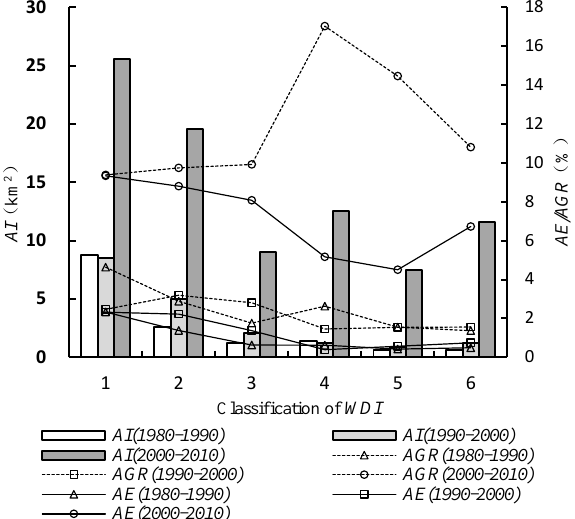
Figure 3. The relationship between road network distance to core cities and urban expansion